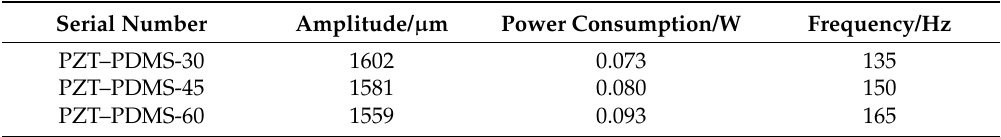
Table 3. Power consumption of the maximum vibrating amplitudes of each design under 40